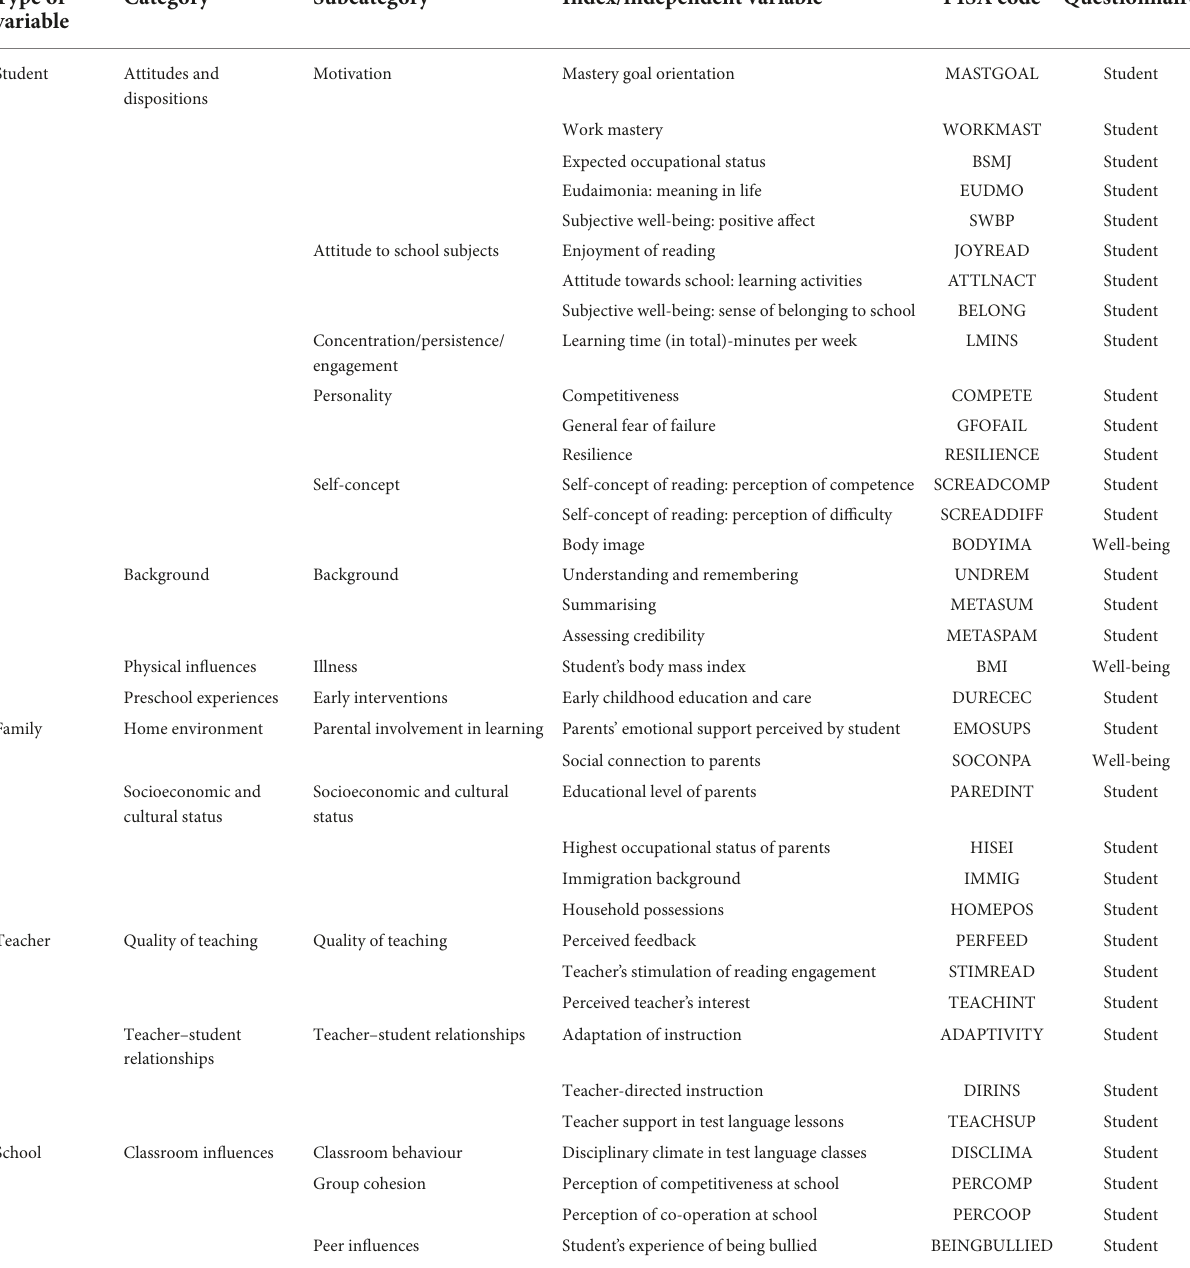
TABLE 2 Independent variables according to Hattie’s’s (2009) categories and subcategories.